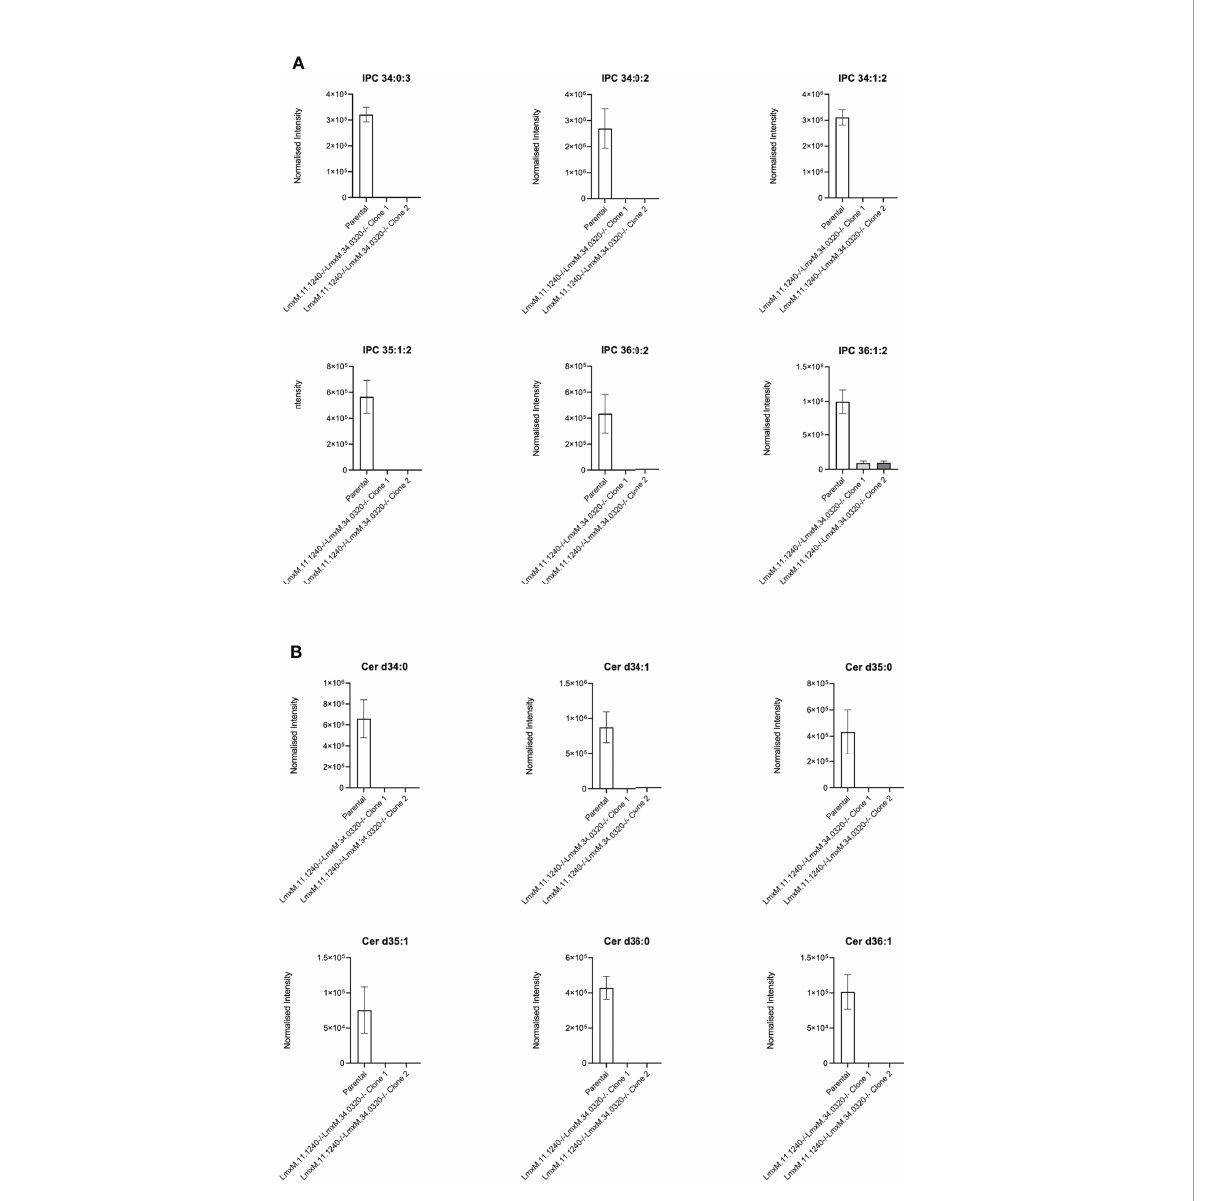
FIGURE 7 Ablation of IPC and ceramide molecular species in L. mexicana . Panel A shows IPC 34:0:3, IPC 34:0:2, IPC 34:1:2, 35:1:2, IPC 36:0:2 and IPC 36:1:2; Panel B shows Cer d34:0, d34:1, d35:0, d35:1, d36:0 and d36:1. The graphs reveal a substantial decrease in the intensity (mean ± SEM) of the sphingolipids in the LmxM.11.1240-/-LmxM.34.0320-/- mutants (n=5) compared to the parental line